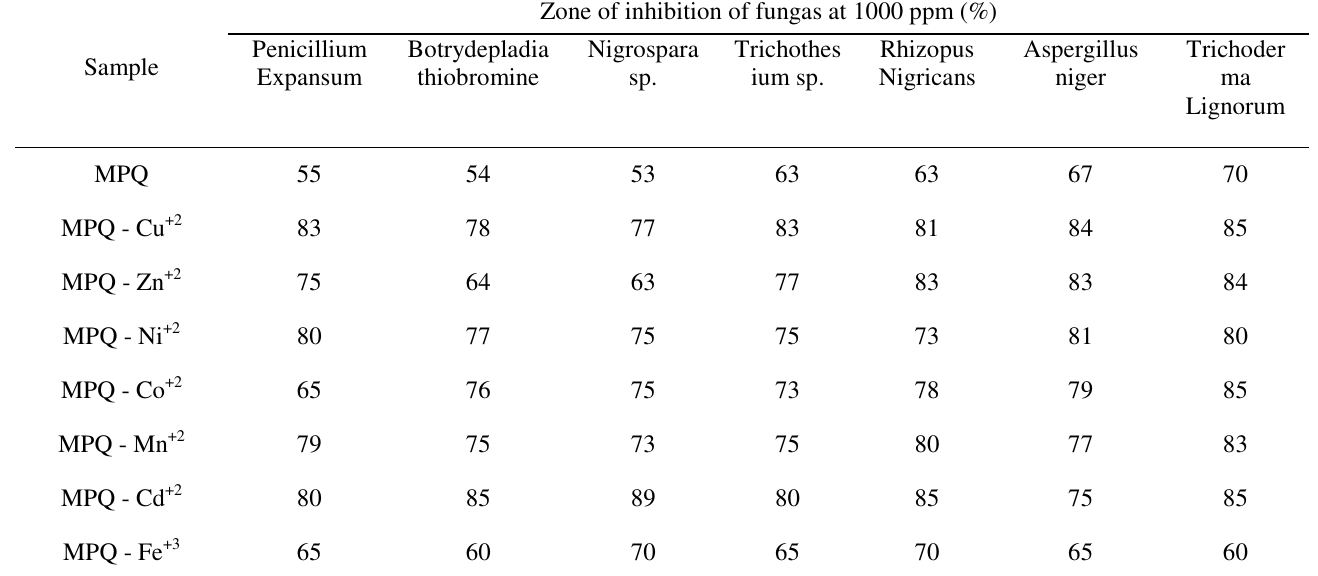
Zone of inhibition of fungas at 1000 ppm